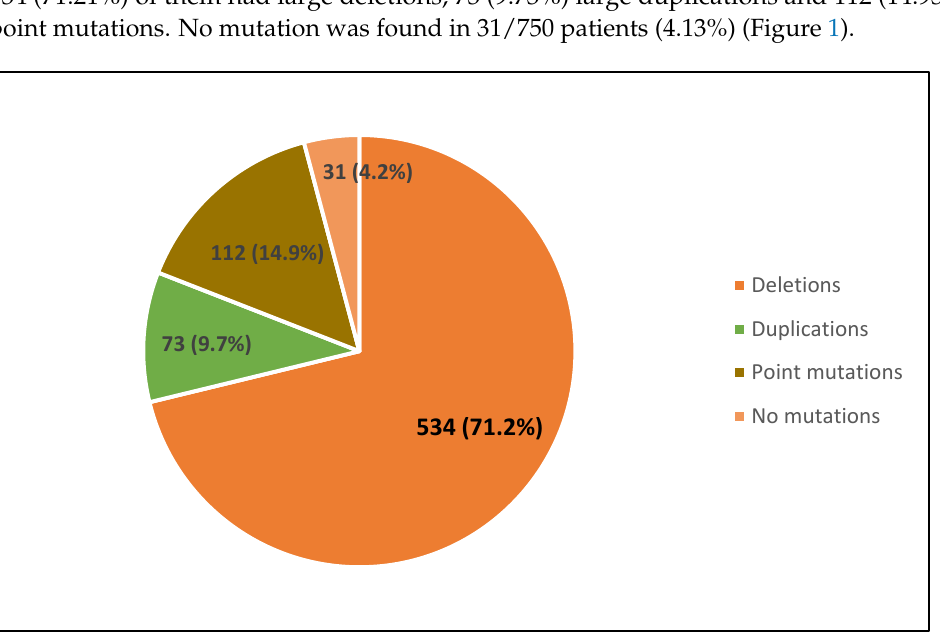
Figure 1. Distribution of the pathogenic DMD variants identified in the study population.